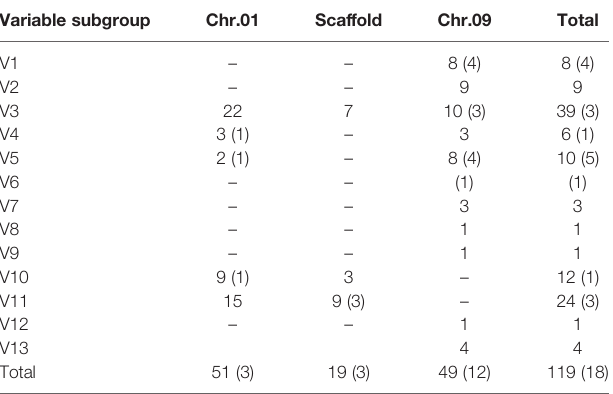
TABLE 2 | Number of variable subgroup members per